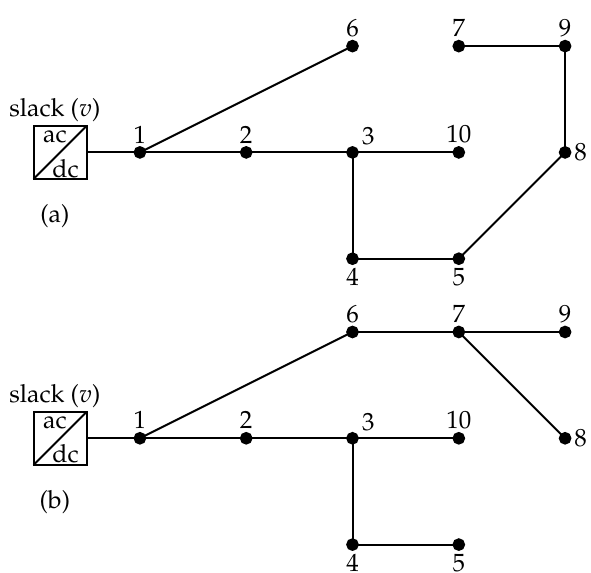
Figure 7. Electrical configuration for the 10-nodes test feeder after optimal reconfiguration for load cases 2 and 3: ( a ) LC 2 , and ( b ) LC 3 .